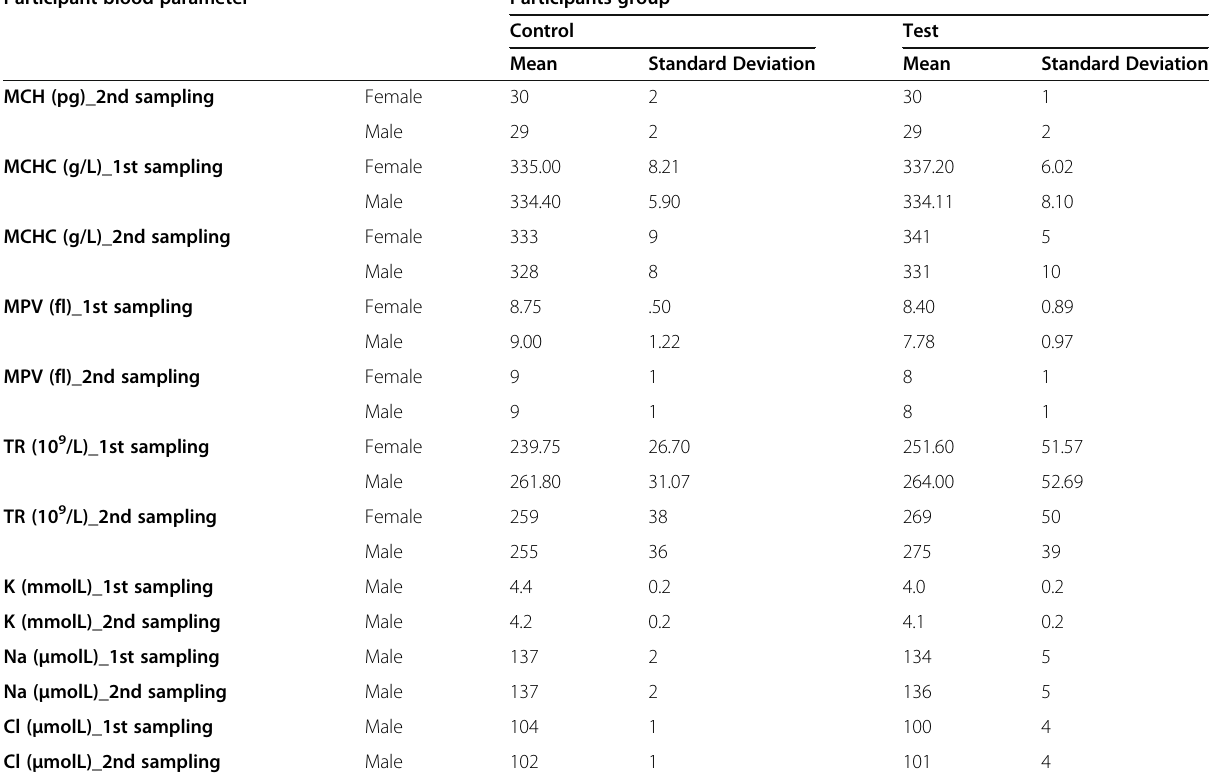
Table 2 Blood parameter value during 1st and 2nd sampling (Continued) Participant blood